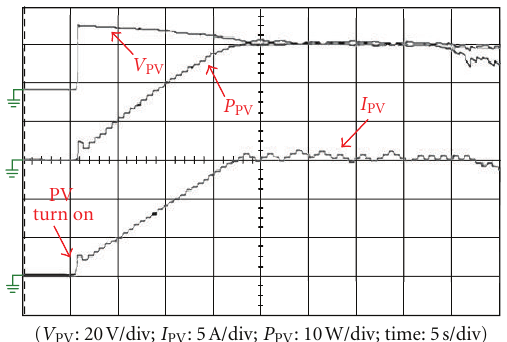
Figure 15: Measured output voltage, current, and power waveforms of PV arrays.